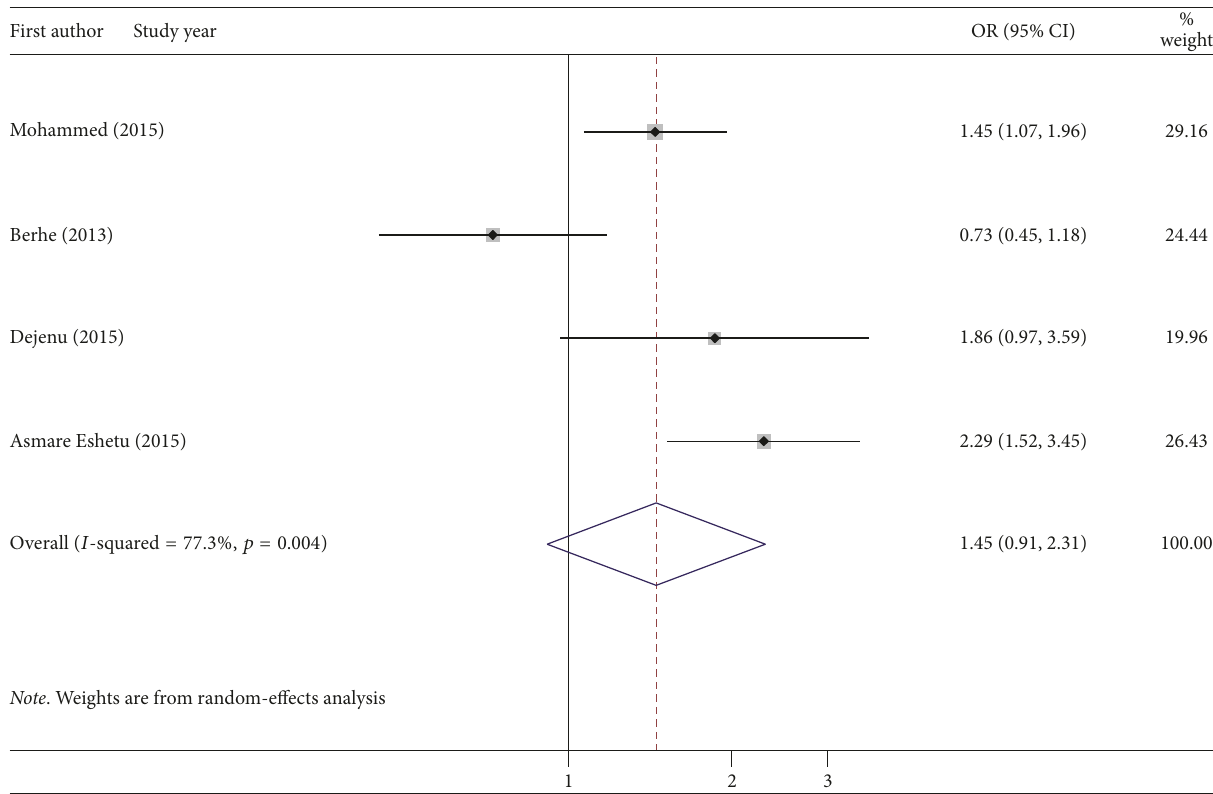
Figure 4: Forest plot presenting pooled random-effect size (OR) of females related to males in depressive PLWHIV patients in Ethiopia,